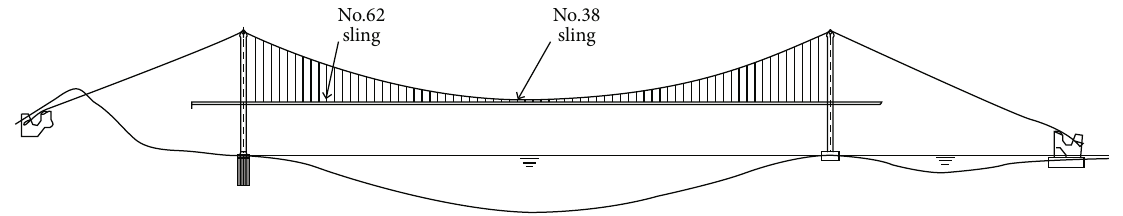
Figure 1: Typical bridge deck samples obtained on di ff erent site.